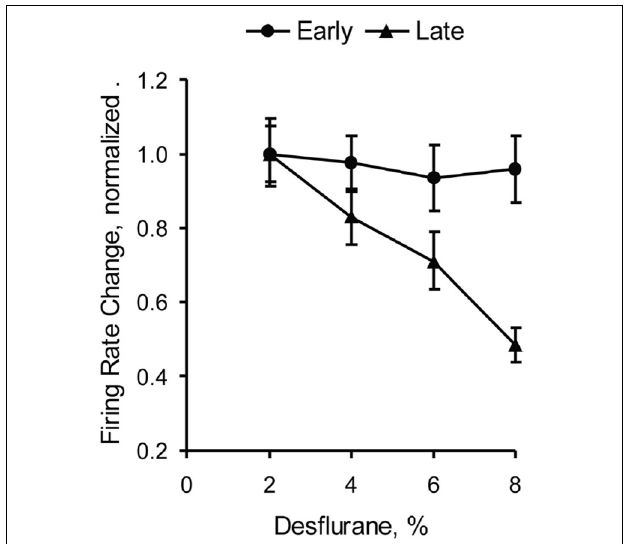
FIGURE 4 | Anesthetic-induced unconsciousness is not correlated with effects on early evoked potentials. This study of visual evoked potentials in rats demonstrates a clear dose-dependent effect of the inhaled anesthetic desflurane on long-latency potentials, with sparing of early potentials reflecting processing in primary visual cortex. Reproduced from Hudetz et al. (2009), Anesthesiology, with permission.